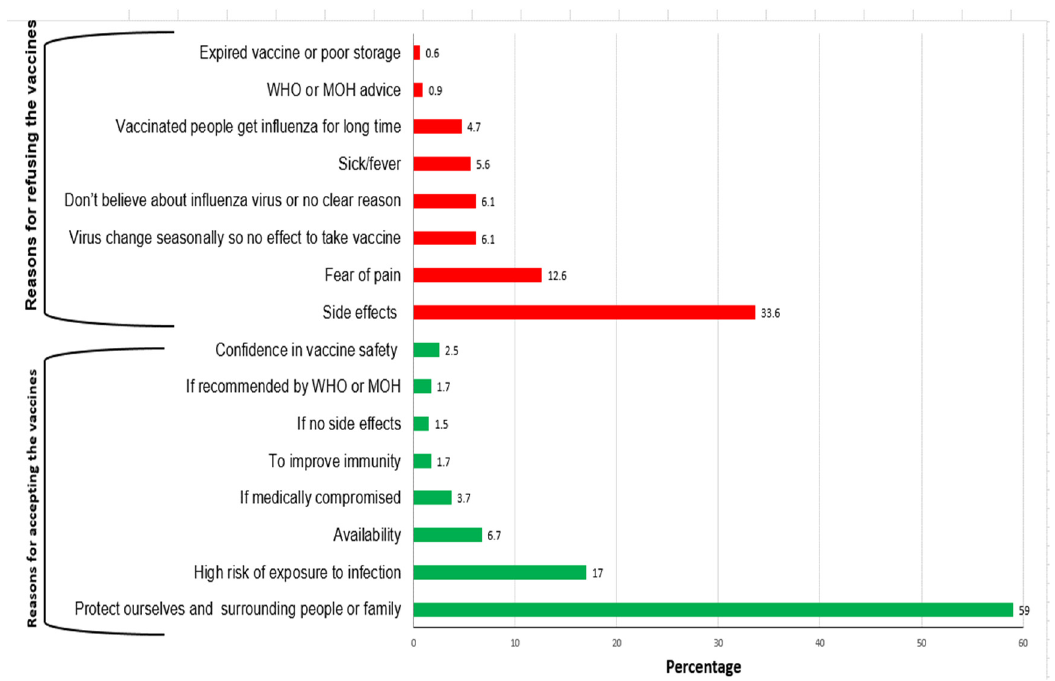
Figure 3. The reasons for accepting or refusing the vaccine among health care workers.